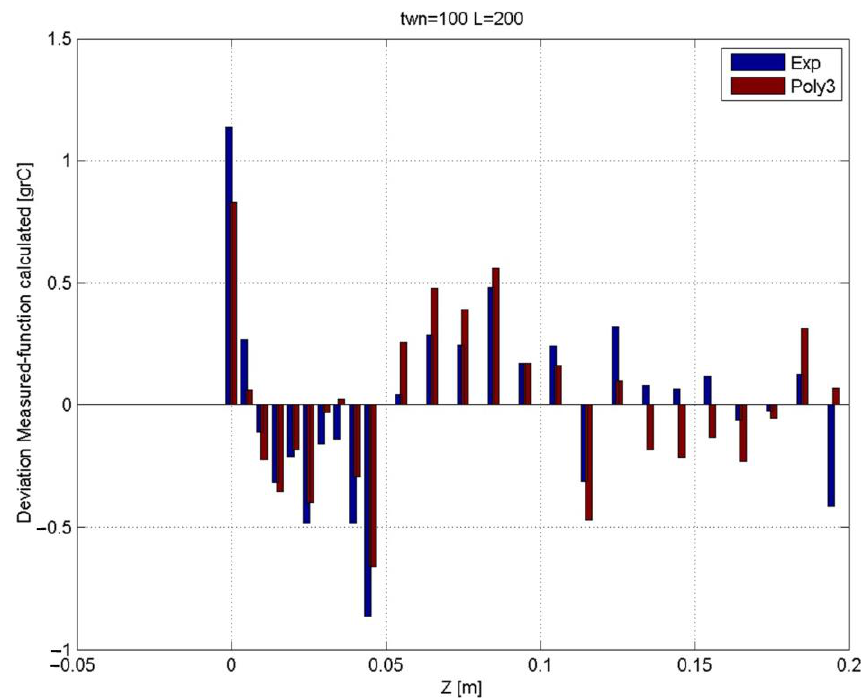
Figure 4. The comparative deviations for “exponential” and third-degree polynomial approaches ( t O , n = 100 ◦ C; α g = 0 ◦ ).